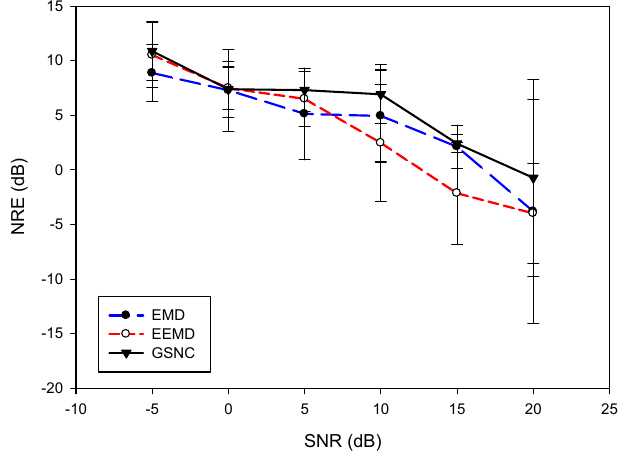
Figure 7. Comparison of overall average NER dB with various SNR for the proposed GSNC, EMD and EEMD schemes (EMG noise).